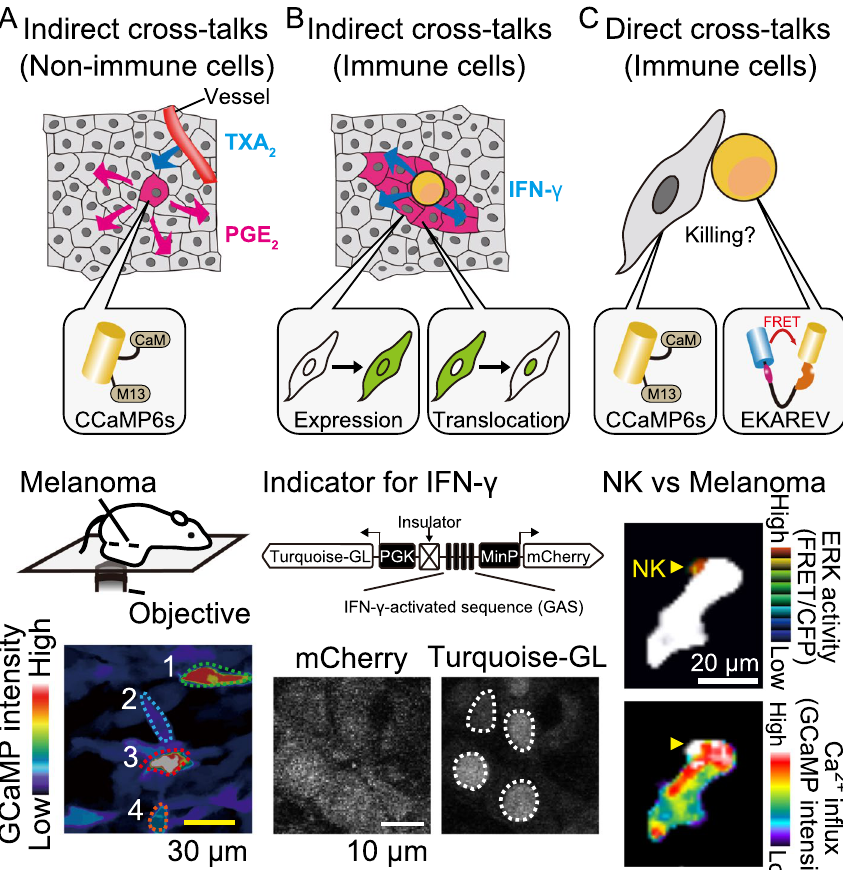
Fig. 2 2P-IVM with fluorescent indicators to reveal the cross-talks between tumor cells and surrounding cells in the tumor microenvironment including both immune and non-immune cells. Indirect cross-talks between A tumor cells and non-immune cells, B tumor cells and immune cells, and C direct cross-talks between tumor cells and immune cells can be visualized by using 2P-IVM with fluorescent indicators (gray cells: tumor cells; magenta cells: tumor cells receiving signals via signaling molecules, TXA 2 or IFN-γ; yellow cells: T cells or NK cells). Melanoma cells expressing GCaMP6s were imaged using 2P-IVM ( A , bottom). The image represents the maximum intensity projection for 10 min. Images were adapted courtesy of Konishi et al. [36]. Schematic representation of the fluorescent indicator for IFN-γ ( B , bottom). Melanoma cells expressing this fluorescent indicator were imaged using 2P-IVM. Images represent the mCherry and turquoise-GL-NLS of parental cells. Images were adapted by courtesy of Tanaka et al. [38]. Melanoma cells expressing GCaMP6s were imaged in the lung using 2P-IVM ( C , bottom). Top, FRET/CFP ratio of an NK cell is shown. Melanoma cell is shown in white. GCaMP6s intensity is displayed in pseudo-color (bottom). The NK cell is shown in white. The images were adapted by courtesy of Ichise et al.